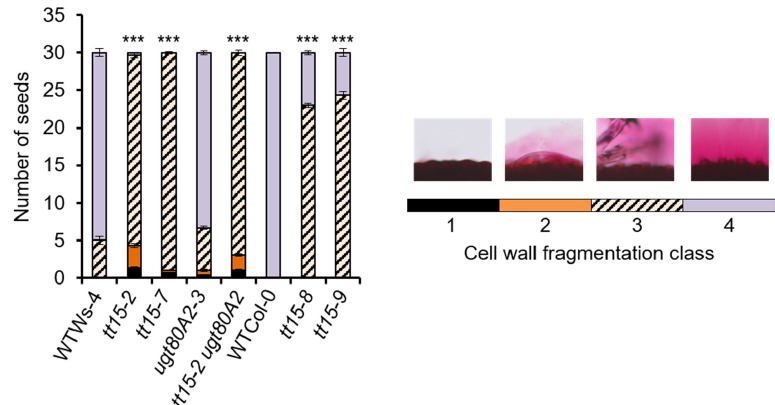
Figure 4. tt15 mutants are defective for the fragmentation of the outer primary cell wall of seed coat epidermal cells on imbibition. Cell wall fragmentation was quantified in four different classes following ruthenium red staining for 30 seeds/genotype after imbibition in water for 16 h. Classes 1 to 4 were assigned according to the images of the seed surface shown above the corresponding shaded bars used on the graph; in 1, the primary cell wall remained intact, in 2 the primary cell wall was slightly dissociated from the seed surface as blistering, in 3 large slivers of primary cell wall material were observed within the mucilage leaving columella tops naked, and in 4 fragmentation occurred for cells individually, leaving primary cell wall fragments attached to the tops of columella. Error bars represent SE values ( n = 3). Pearson chi-squared test comparing to wild-type *** p < 0.001. Similar results were obtained in an independent experiment using biological replicates for each genotype. Wild-type, WT; tt15-2 ugt80A2-3, tt15-2